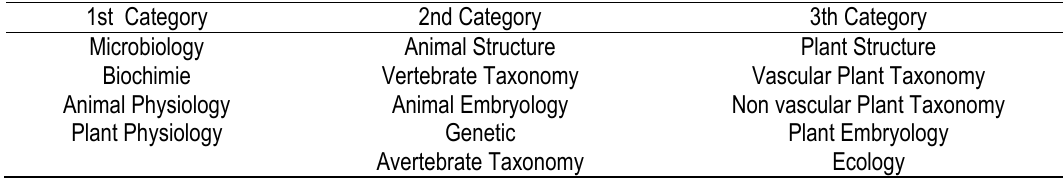
Table 2. insCategory of Science Practicum Courses Based on Materials, Instruments and